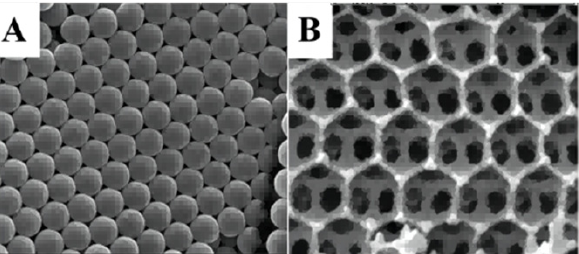
Figure 7. ( A , B ) SEM images of colloidal crystal template and CeO 2 /3DOM TiO 2 [44]. Pt-particle-decorated 3DOM carbon-coated TiO 2 and g-C 3 N 4 were combined [45] to construct an all-solid-state catalyst for CO 2 artificial photoconversion. Slow photon effect and carbon coat optimized the absorption capability of light. The exquisite design drove vectorial electrons from TiO 2 @C to Pt particles and then fell to g-C 3 N 4 , which facilitated the carrier separation. The Z-scheme that consist of two isolated systems has three com- ponents and converts CO 2 to CH 4 with H 2 O at a yield of 65.6 µmol g − 1 h − 1 . To enhance the surface enrichment of CO 2 , Wu et al. [46] fabricated 3DOM perovskite-type Pt n /SrTiO 3 , in which Pt nanoparticles can take in photoelectrons from SrTiO 3 and transfer CO 2 to CO and CH 4 (Figure 8). Pt 2 /3DOM SrTiO 3 exhibited the highest CH 4 yield of 26.7 µmol g − 1 h − 1 .